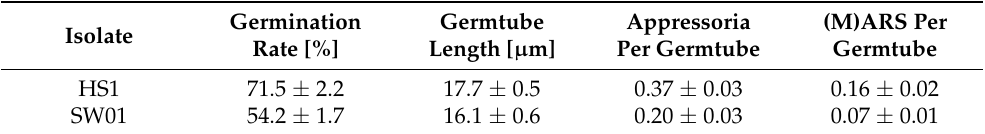
Table 2. Development of Venturia inaequalis isolates HS1 (wild type) and SW01 (melanin-deficient) on glass slides at 22 ± 2 ◦ C, 16 h p.i. Mean ± standard error of the mean (n = 700). Germination Isolate Rate [%]